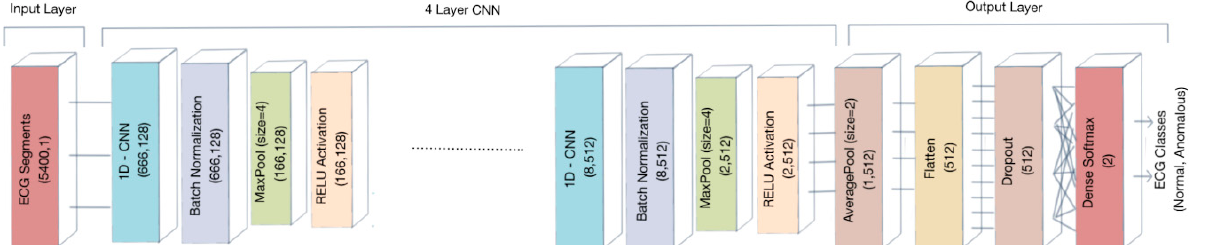
Figure 3. Architecture of the proposed 1D ‐ convolutional neural network (CNN) model. Table 4. Detailed parameters of the proposed 1D ‐ CNN model. The 1D max pooling resizes the input representation by taking the maximum value on the window defined by pool size. The strides specify how much the pooling window moved for each pooling step. The pooling level was placed before ReLU to reduce